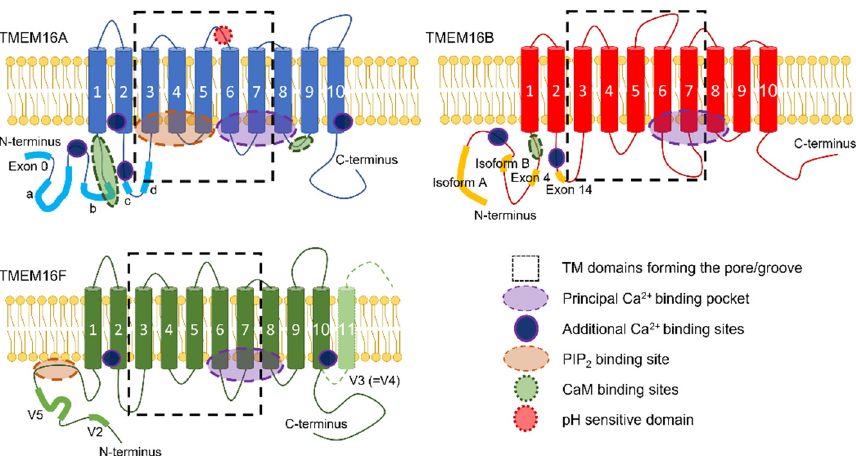
Figure 1. Topological diagram of TMEM16x proteins, showing the position of the alternative spliced exons and a range of functional domains. The boxes (broken lines) highlight the TMs involved in the formation of the ion/lipid pathways in TMEM16x. The approximate position of each splicing variant is labelled using the nomenclature described in the main text. The diagrams also show the approximate position of a range of functional domains, including (1) the principal Ca 2+ -binding pocket, which encompasses conserved acidic residues located in TM6-8; (2) additional regulatory Ca 2+ -binding sites; (3) putative calmodulin (CaM)-binding sites; (4) putative phosphatidylinositol 4,5-bisphosphate (PIP 2 )-binding sites; and (5) the pH-sensitive domain on the extracellular loop between TM5 and TM6 of TMEM16A.